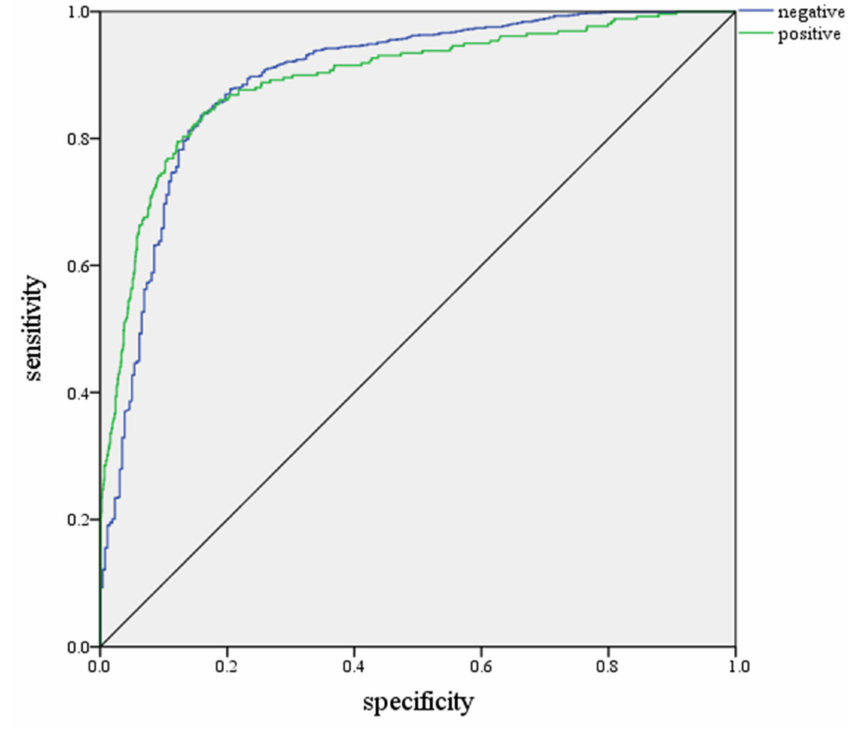
Figure 2. ROC Curve. ROC =